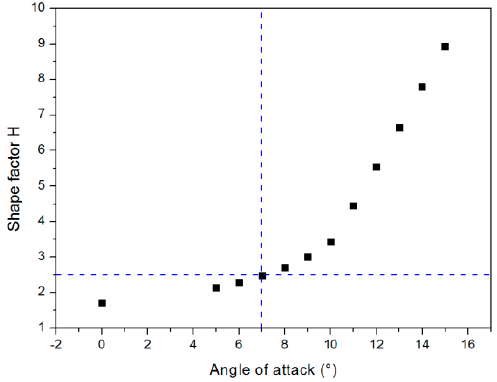
Figure 5. XFOIL simulation expressing the shape factor H versus the angle of attack for 22